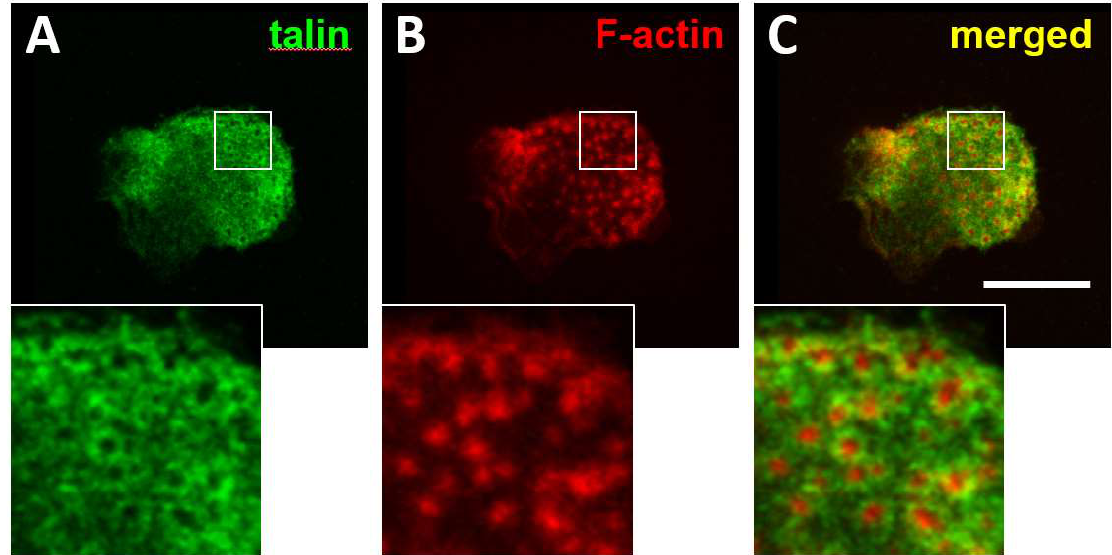
Figure 2. Formation of podosomes in multiple myeloma cells. CD138 positive cells were isolated from bone marrow aspirates from multiple myeloma patients. Isolated cells were seeded on fibronectin-coated coverslips and incubated for 24 h. Cultures were fixed with 4% paraformaldehyde and permeabilised with 0.05% Triton X-100 and immuno-stained to detect the distribution of talin ( A ) and F-actin ( B ). Merged images are shown in ( C ). Magnification of the boxed areas with talin, vinculin and merged staining are shown at the bottom. Bar 10 µm.